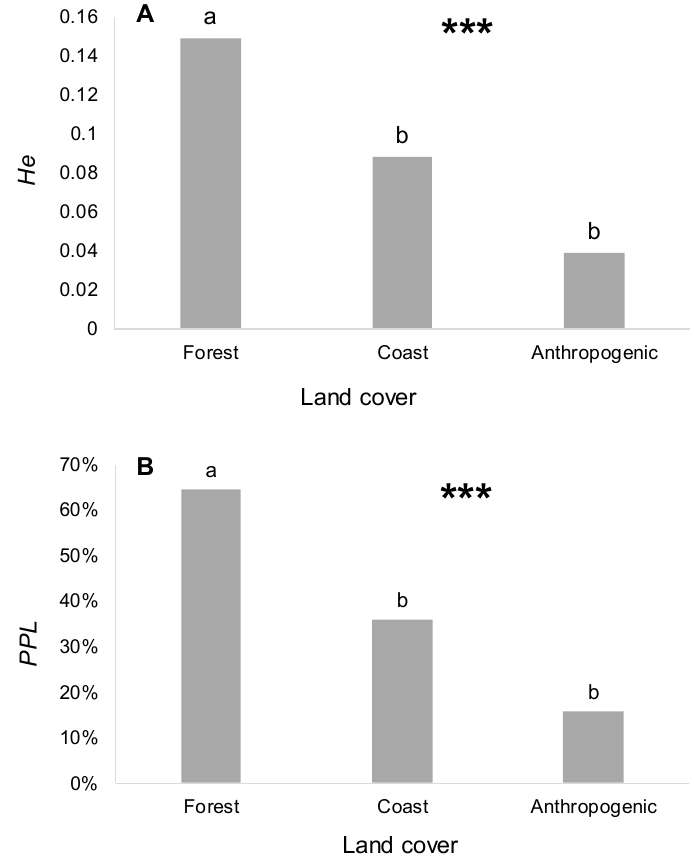
Figure 4. Relationship between the proportional mean value of He ( A ) and PPL ( B ) and land cover characteristics (forest, coastal, and anthropogenic). Results of Kruskall-Wallis test: *** p < 0.05, letters represent results of multiple comparisons test.